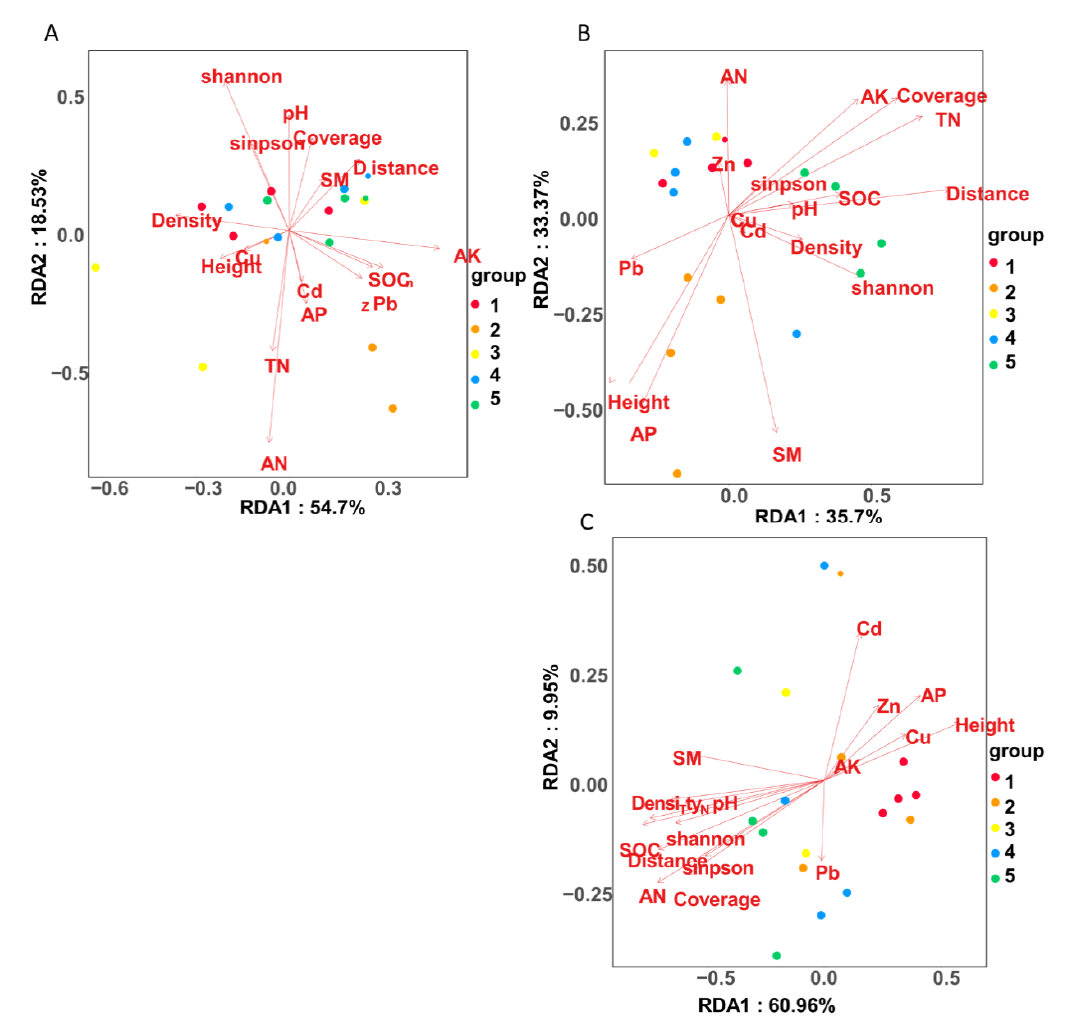
Figure 10. Ordination biplots of redundancy analysis (RDA) analysis of bacteria community structure, physical and chemical properties of soil and plant between treatments at 5, 20, 50, 100, and 400 m from the curb G109 highways at altitudes of ( A ) 4000 m, ( B ) 4600 m, and ( C ) 5200 m.